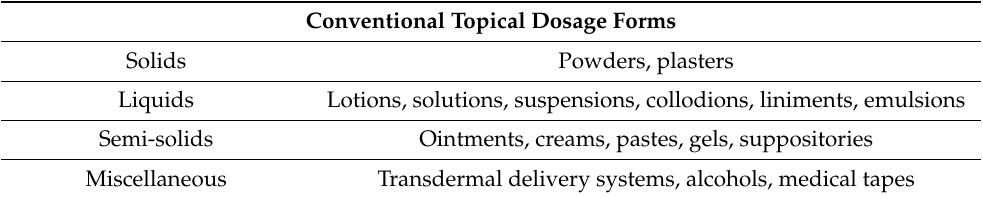
Table 2. Different topical dosage forms that can be used in miniaturized diffusion cell device.